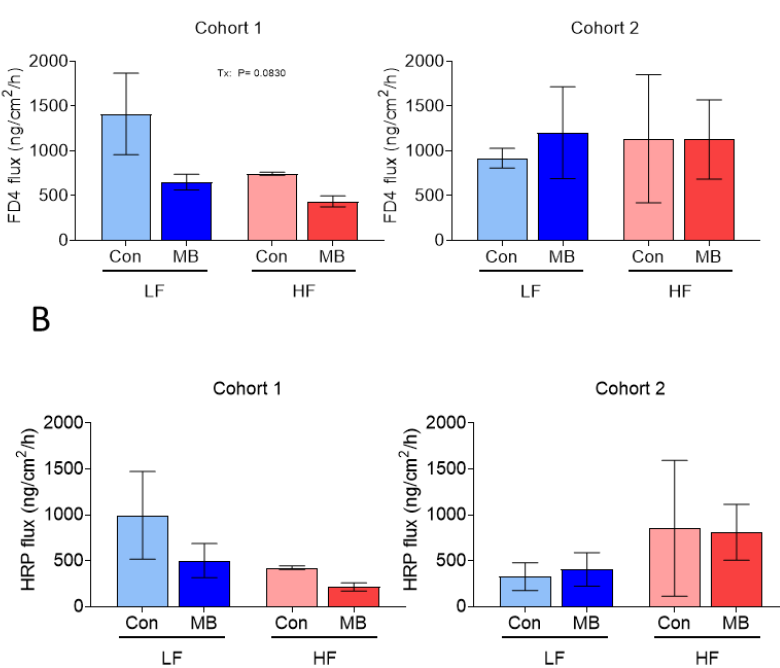
Figure 3. E ff ect of monobutyrin supplementation on intestinal permeability in mice fed either an LF or HF diet for 6 weeks. ( A ) fluorescein isothiocyanate-dextran (FD)4 flux (paracellular pathway) and ( B) horseradish peroxidase (HRP) flux (transcellular pathway) in the colon of mice fed either a LF or HF with or without 0.25% MB supplementation for 6 weeks. Two-way analysis of variance followed by Sidak’s post hoc test was used to determine di ff erences among groups. Values are means ± SEMs; n = 2–3 / group. Significant ( p < 0.1) main e ff ects are listed on graphs where they occur. FD4, fluorescein isothiocyanate-dextran 4000; HRP, horseradish peroxidase; HF, high-fat diet; LF, low-fat diet; Con, drinking water only control; MB, monobutyrin as 0.25% MB ( w / v ) in drinking